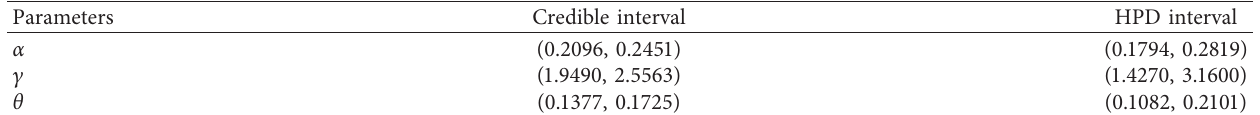
Table 9: Credible and HPD intervals of the parameters α , c , and θ for the failure time data.